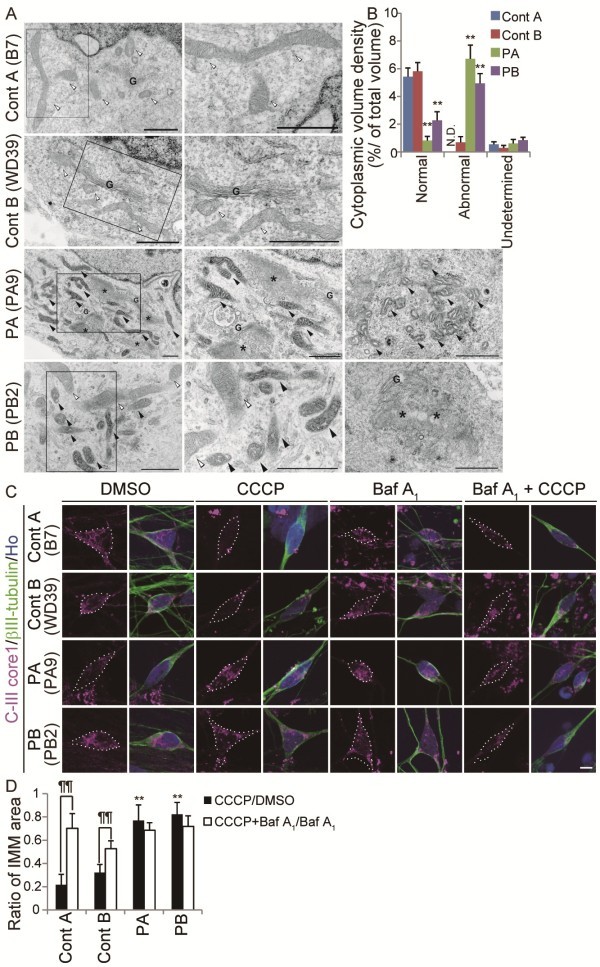
Dysregulation of mitochondrial homeostasis in PARK2 iPSC-derived neurons. (A) Electron micrographs of control A (B7), control B (WD39) and PARK2 (PA9 and PB2) iPSC-derived neurons. Boxed areas are shown in the enlarged images to the right. Control mitochondria showed a characteristically long, cylindrical profile with well-organized cristae, and the electron density of the matrix was relatively low (white arrowheads). By contrast, increased electron density of the matrix was evident in PARK2 mitochondria (black arrowheads), and the cristae often appeared swollen. As shown in PB2, some of the neurons contained both morphologically intact (white arrowheads) and abnormal (black arrowheads) mitochondria. Furthermore, abnormal tubulovesicular structures (asterisks) were observed adjacent to the Golgi cisternae (G). (B) The relative perikaryal volume of the abnormal mitochondria was significantly increased, and that of the normal mitochondria was decreased, in PARK2 neurons compared with control neurons. (C) Double labeling for the IMM marker, ComplexIII coreI (CIII-Core I; magenta) and βIII-tubulin (green) of control A (B7), control B (WD39) and PARK2 (PA9 and PB2) iPSC-derived neurons. The volume of the IMM area was reduced in control neurons treated with CCCP, but not in PARK2 neurons treated with CCCP. Administration of Baf A1 rescued the CCCP-induced phenotype in control neurons. (D) The CCCP/DMSO ratio in control A (B7 and YA9) and B (WD39) neurons was reduced after CCCP treatment. This reduction was not observed in PARK2 (PA1, 9 and 22, and PB2 and 20) iPSC-derived neurons (black bars indicate CCCP/DMSO ratio; white bars indicate Baf A1+CCCP/Baf A1 ratio). ** indicates P < 0.01 compared with the control; ¶¶ indicates P < 0.01 when comparing the black and white bars (Mann–Whitney U-test). At least three experiments were performed for each group, with 5–36 cells quantified per experiment. Scale bars: a, 1 μm; c, 10 μm. Error bars represent the SEM. N.D., not detected.